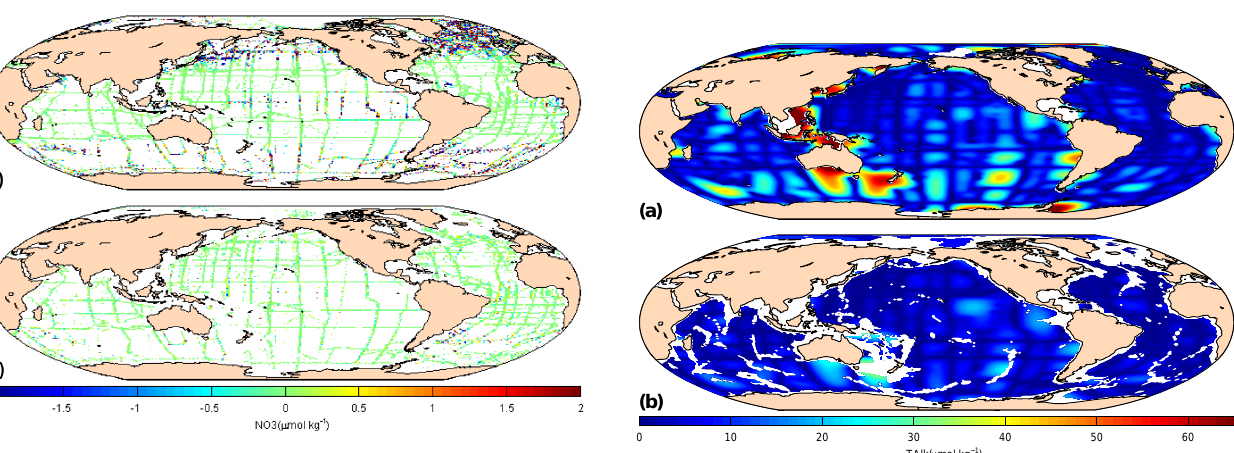
Figure 10. Mapping error for TAlk at 10m (a) and 3000m (b) . Notice how the error increases with distance from transects, creating a spatial pattern of square-like features in the